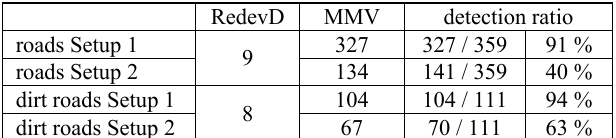
Table 3: disappeared roads